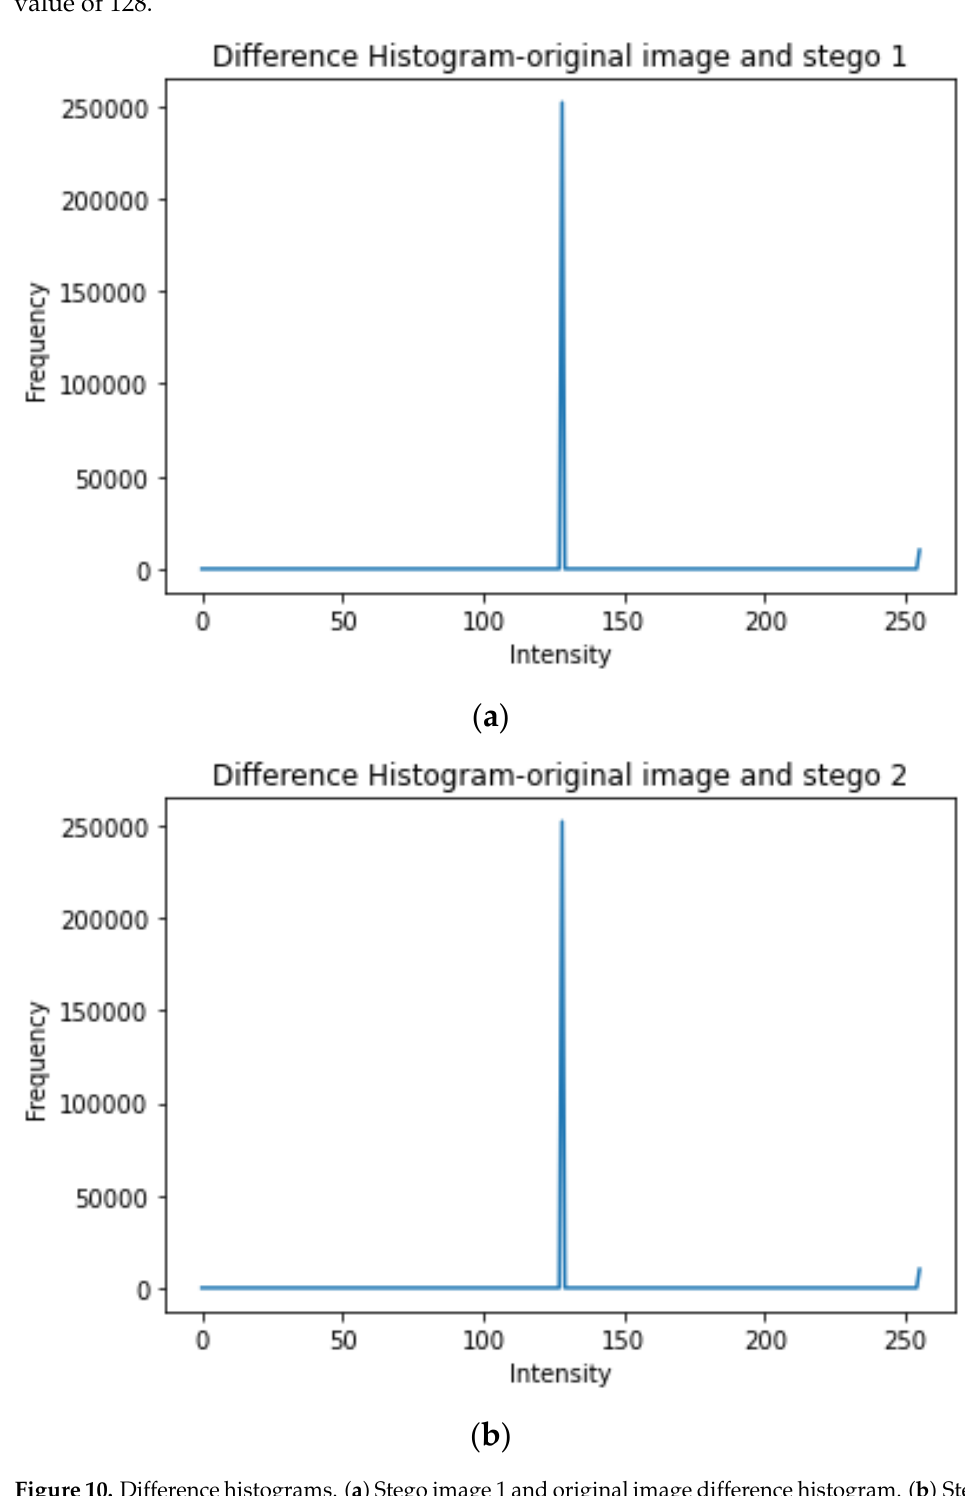
plot shows how many pixels in the image have each gray-level value. For example, a peak at the gray-level value 128 means that there are many pixels in the image with a gray-level value of 128.